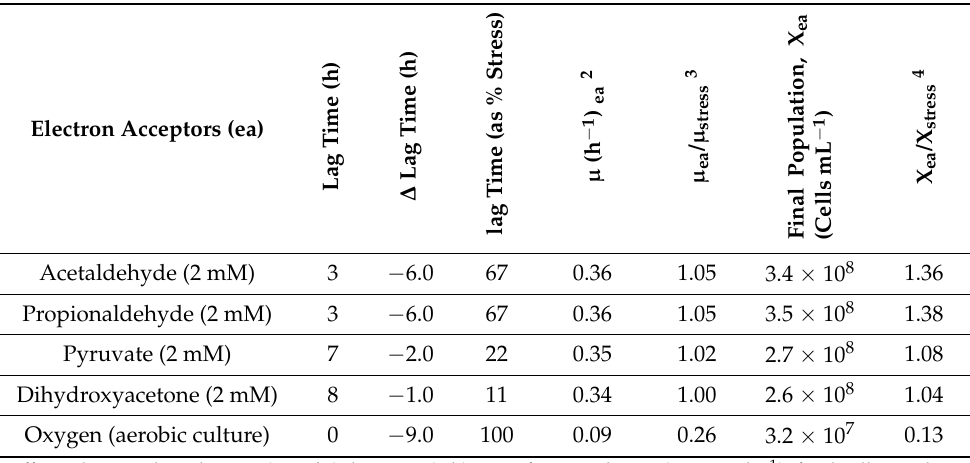
Figure 2. Effect of added propionaldehyde on the growth and metabolism of ethanol stressed (50 g/L) Z. mobilis cultures compared to the effect of an equimolar concentration of acetaldehyde. ( A ) Cell growth; ( B ) propionaldehyde-to-propanol conversion; ( C ) glucose utilization. (cid:4) , (cid:3) ethanol-stressed culture without aldehyde supplementation; (cid:117) , , , ethanol-stressed culture with 2 mM (120 mg/L) added propionaldehyde ( (cid:52) propionaldehyde; (cid:53) 1-propanol); (cid:108) , ethanol-stressed culture with 2 mM (90 mg/L) added acetaldehyde. Table 1. Summary of the effects of various metabolic electron acceptors on the growth of ethanol stressed (50 g/L) 1 Z. mobilis